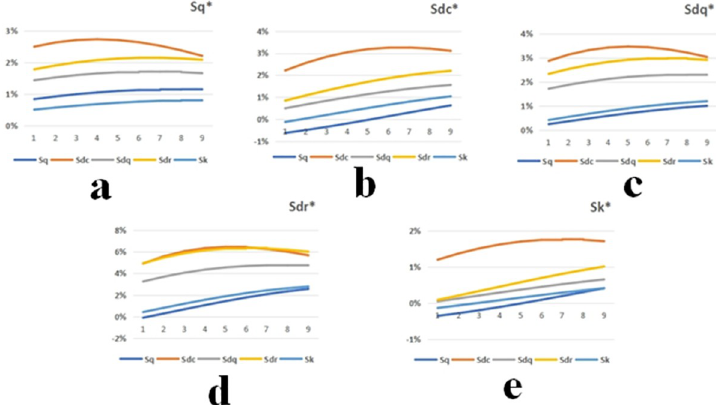
Fig 8. Influence of unworn surface parameters on the worn surface parameters. (a) The change rate curve of Sq � . (b) The change rate curve of Sdc � . (c) The change rate curve of Sdq � . (d) The change rate curve of Sdr � . (e) The change rate curve of Sk � .